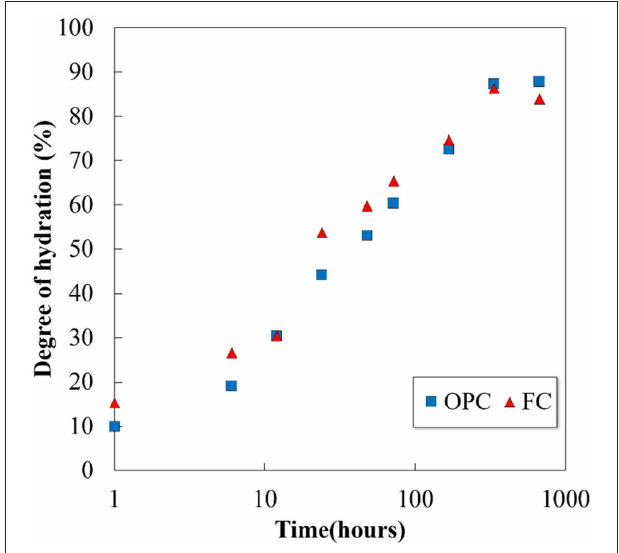
FIGURE 3 | Hydration degree of cements as a function of hydration time determined by XRD.